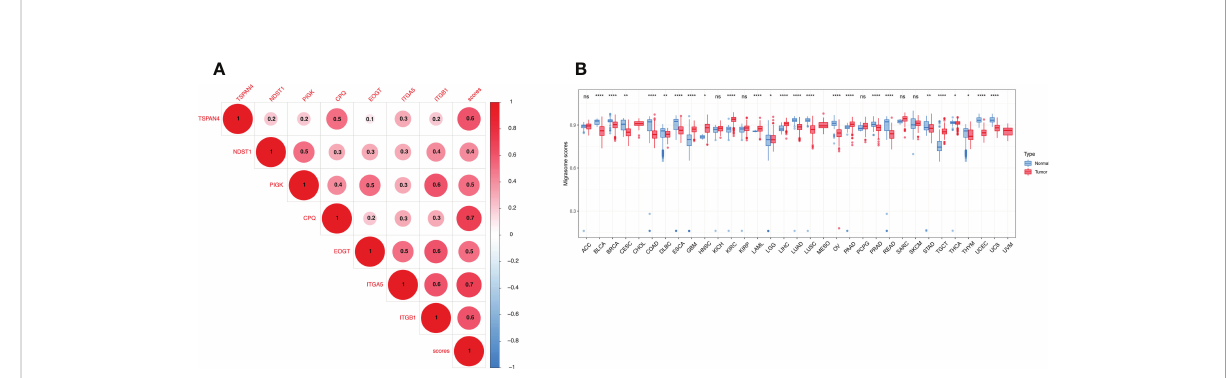
FIGURE 5 Expression of the migrasome scores. (A) Association of the MRGs. Higher values represent stronger correlations. (B) Migrasome expression in tumor and normal tissues of The Cancer Genome Atlas and The Genotype-Tissue Expression cohorts. Data are represented as mean ± standard deviation. *P < 0.05, **P < 0.01, and ****P < 0.0001, ns, no signi fi